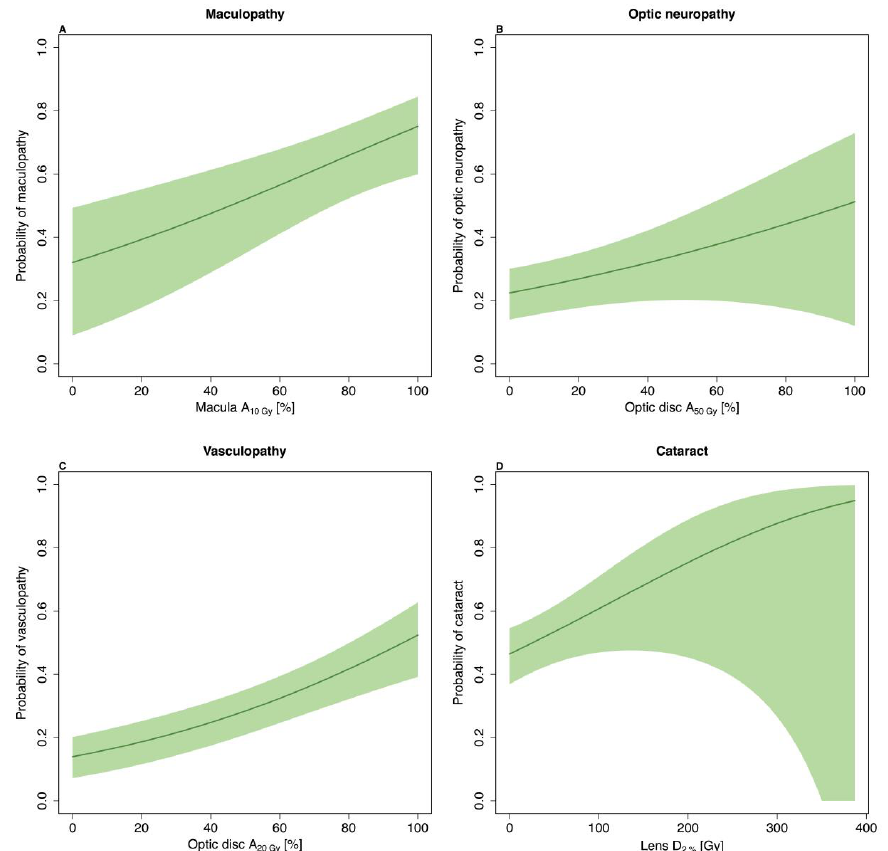
Figure 3. ( A ) Dose–response of maculopathy as a function of the area of macula receiving 10 Gy (macula A 10Gy ). The model adjusts for optic disc–tumour distance (2.4 mm). ( B ) Dose–response of optic neuropathy as a function of optic disc A 50Gy . The model adjusts for optic disc–tumour distance and optic disc A 50Gy (39.4 Gy). ( C ) Dose–response of vasculopathy as a function of optic disc A 20Gy . ( D ) Dose–response of cataract as a function of lens D 2% . The model adjusts for age at treatment (62 years) and largest base dimension (11.3 mm). The shaded areas represent the 95% confidence interval of the risk